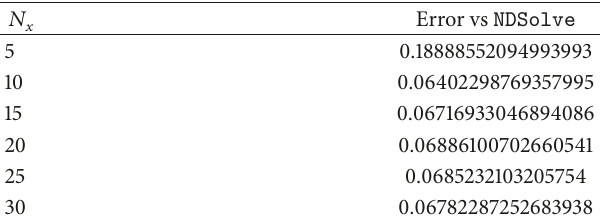
Table 2: Maximum absolute error in the presented method’s solution of the problem described by Example 2 at time 𝑡 = 0.5 .